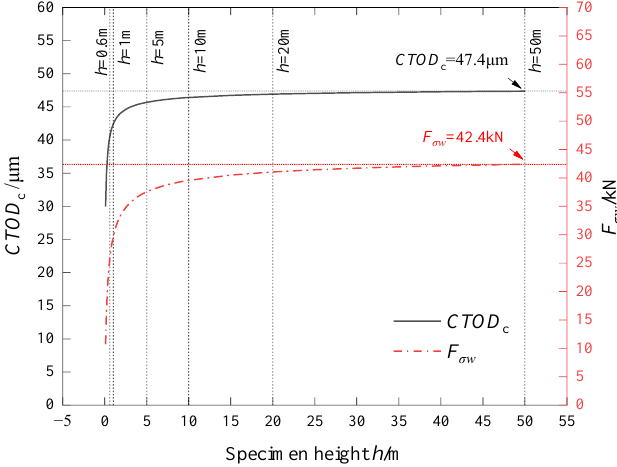
Figure 11. CTOD c and F σ w of specimens with different Figure 11. C T OD and F of specimens with different sizes.  w c